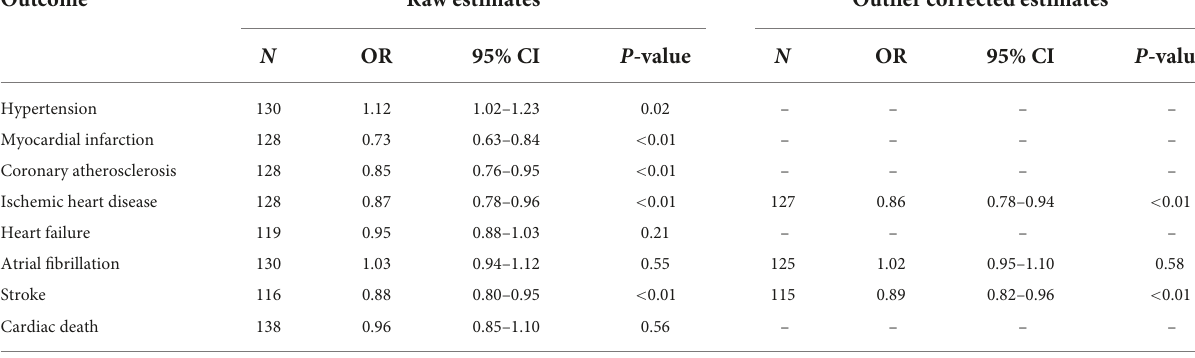
TABLE 2 The Mendelian randomization pleiotropy residual sum and outlier (MR-PRESSO) tests of the relationship between telomere length (TL) and cardiovascular diseases (CVDs). Outcome Raw estimates Outlier corrected estimates